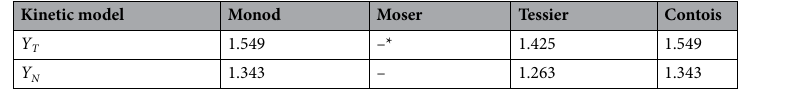
Table 4. Calculation results of Y T , Y N and S min based on different models. *The yield coefficient cannot be calculated directly because the value of parameter n is